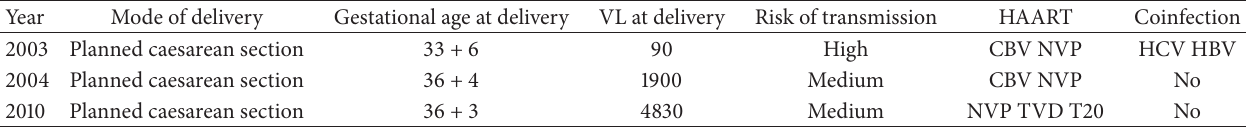
Table 6: Mother-to-child